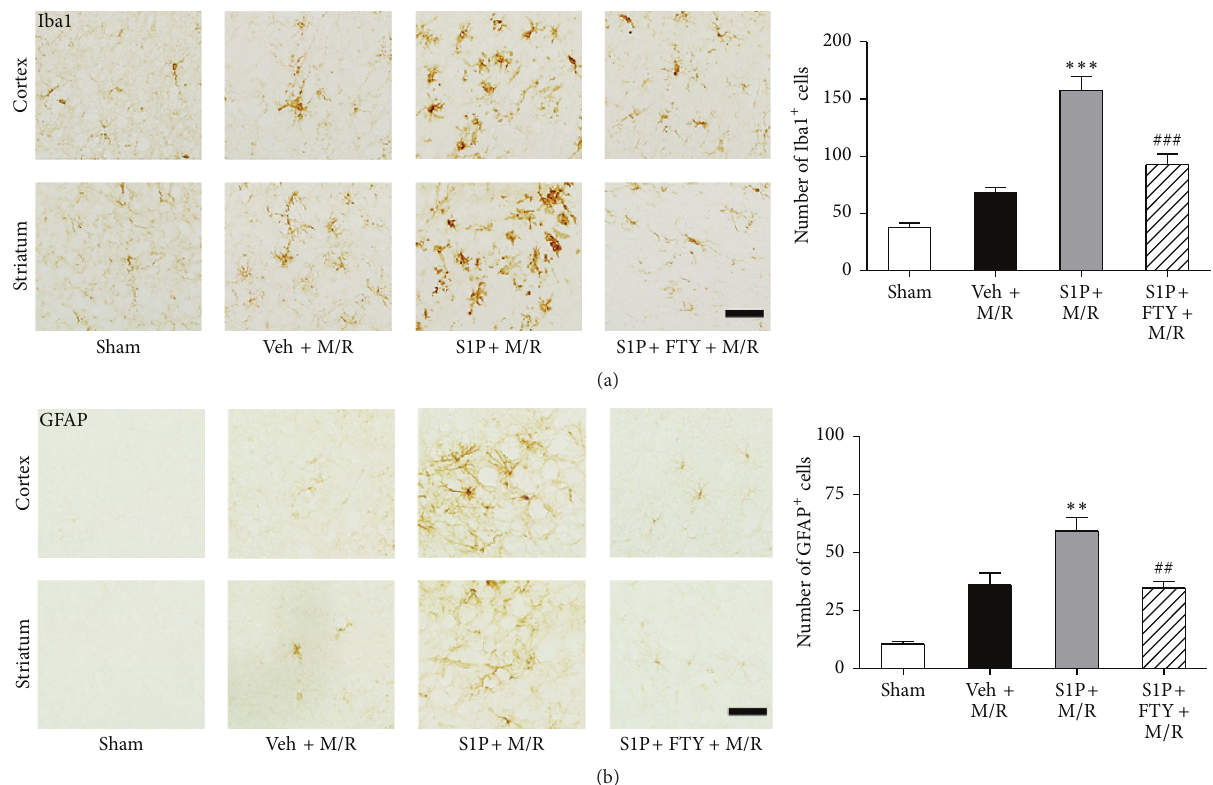
Figure 6: Activation of S1P signaling induces augmented microglial activation and astrogliosis following M/R injury. S1P or vehicle (veh) was injected into the corpus callosum 24 h prior to M/R challenge (60 min occlusion followed by 22 h reperfusion). FTY720 (FTY) was administered into mice 30 min prior to 60 min occlusion. Activation of microglia or astrocytes was assessed 22 h after reperfusion. Representative microphotographs of brain sections immunolabeled against Iba1 (a) or GFAP (b) and their quantitative analysis in groups of sham, veh + M/R, S1P + M/R, and S1P + FTY + M/R. ∗∗ 𝑃 < 0.01 and ∗∗∗ 𝑃 < 0.001 , compared with M/R group (veh + M/R) (Newman- Keuls test). ## 𝑃 < 0.01 and ### 𝑃 < 0.001 , compared with the S1P + M/R group (Newman-Keuls test). 𝑛 = 3 per group. Scale bar, 50 𝜇 m.